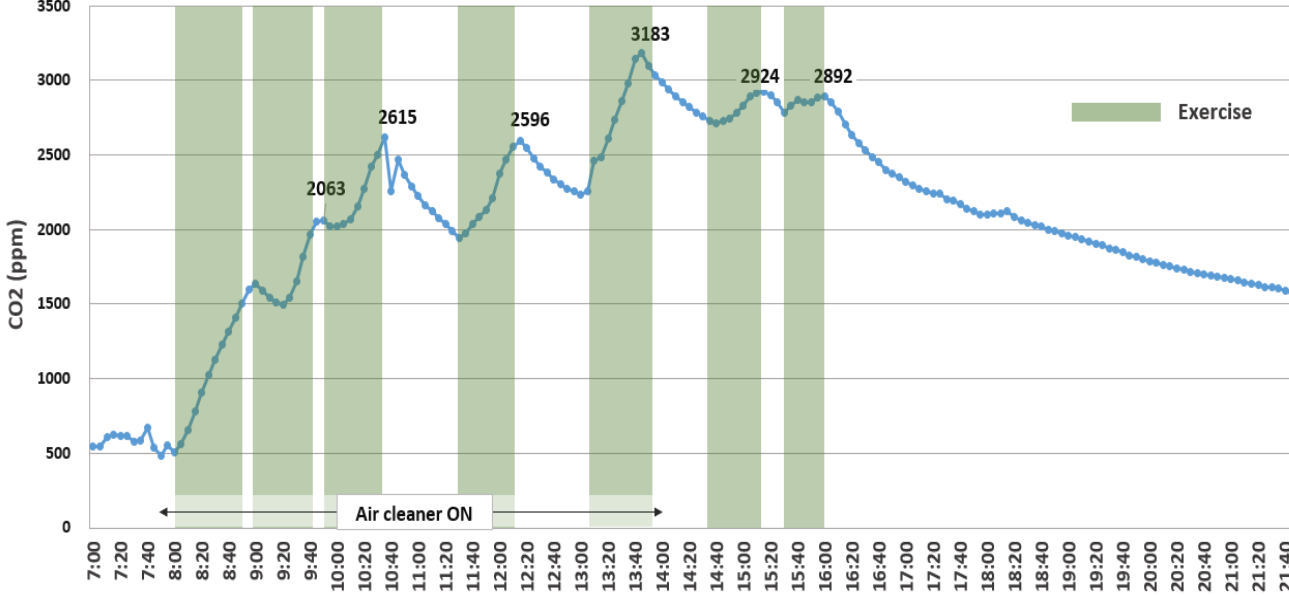
Figure 5. Result of the carbon dioxide (CO 2 ) concentration by physical activity in MPA-space in D